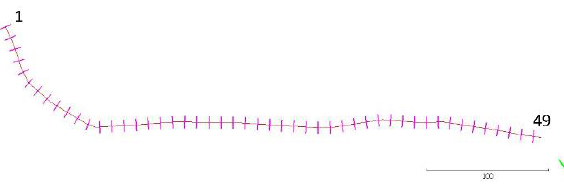
Figure 12. Subdivision of Corso Matteotti in 49 sections equally spaced 10 m apart along the polyline drawn in correspondence with the road centreline. Punctual comparison was performed at the intersection between the 50 polylines.